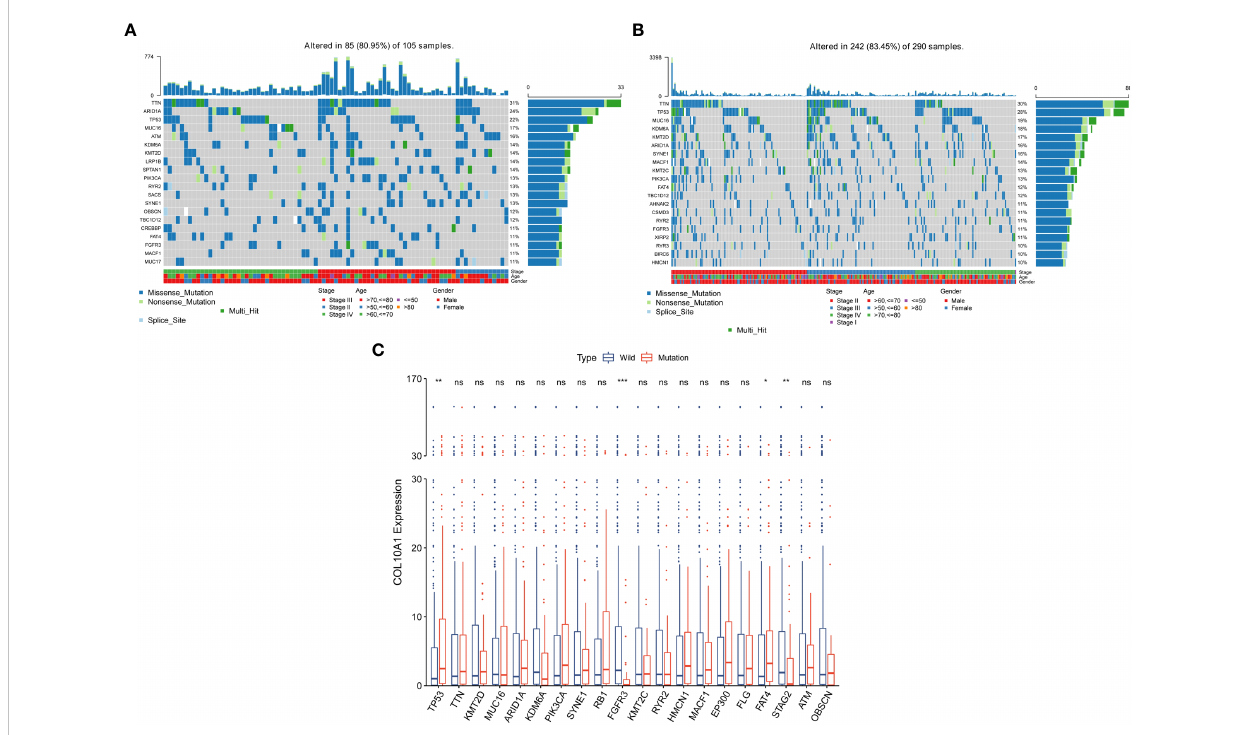
FIGURE 6 Somatic mutation analysis in high and low expression groups of COL10A1. Waterfall plot of the top 20 mutational genes in the high COL10A1 group (A) and low COL10A1 group (B) . Transcriptional levels of COL10A1 between wild and mutational types of top 20 genes with the highest mutation frequencies (C) . * P < 0.05; ** P < 0.01; *** P < 0.001. ns, not signi fi